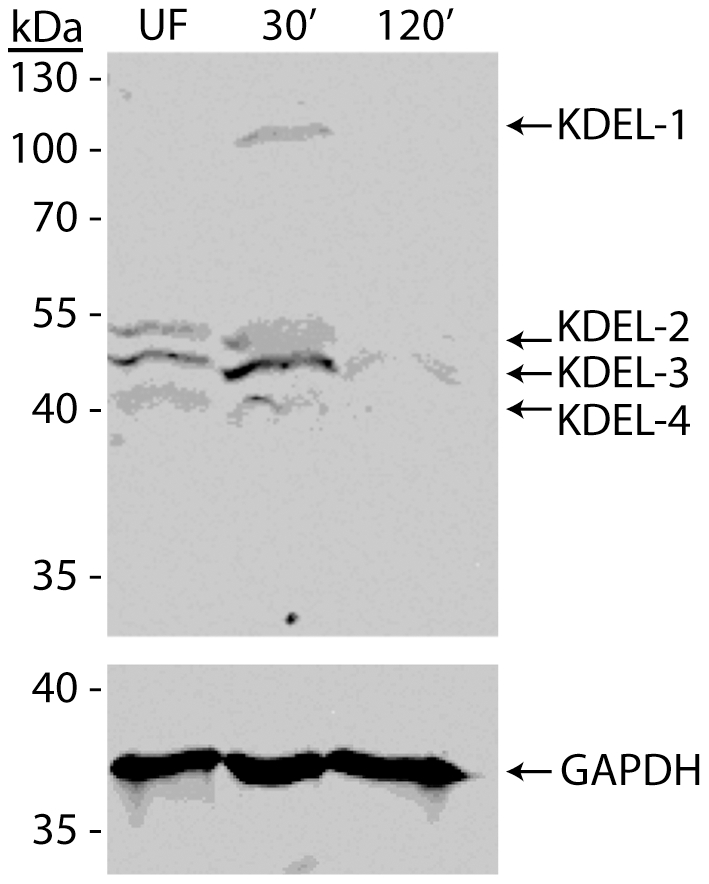
Western blot analysis using a KDEL-specific antibody shows differential expression of four ER resident midgut proteins in response to amino acid feeding in Ae. aegypti mosquitoes.Total midgut protein extracts were prepared from three day old female mosquitoes that were unfed, or amino acid fed and dissected at 30 min. or 120 min. post-feeding. Proteins were resolved by 12% SDS-PAGE gel and Western blotted as described in Materials and Methods. The four unique protein bands were labeled KDEL-1 through KDEL-4 to denote their relative molecular weight, with KDEL-1 being the largest protein. Western blotting with an antibody that recognizes the ubiquitously expressed glyceraldehyde-3P dehydrogenase protein (GAPDH) was performed to control for equal protein loading.